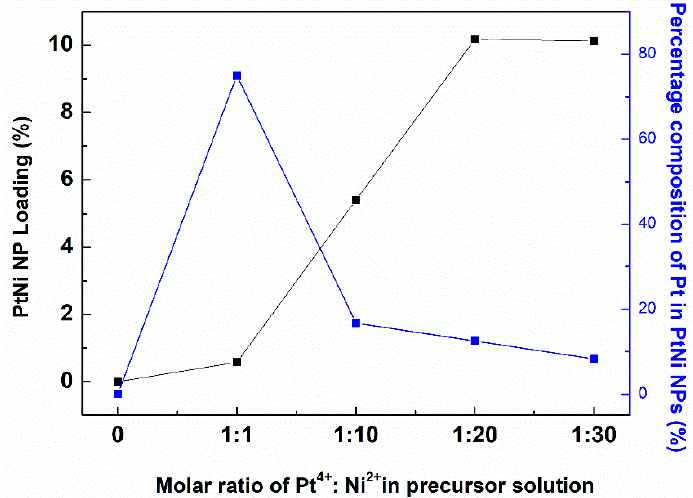
Figure 2. PtNi NPs loading and the percentage composition of Pt in PtNi NPs as a function of the molar ratio of Pt 4+ : Ni 2+ in the precursor solution.